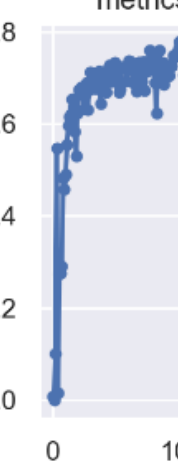
( b ) Figure A8. The precision/recall curve and F 1 Score /confidence curve of YOLOV5m ( a ) PR_curve; ( b ) F1_curve. ( b ) Figure A9. The change of mean average precision (mAP) of YOLOV5m: ( a ) mAP_0.5; ( b ) mAP_0.5:0.95.